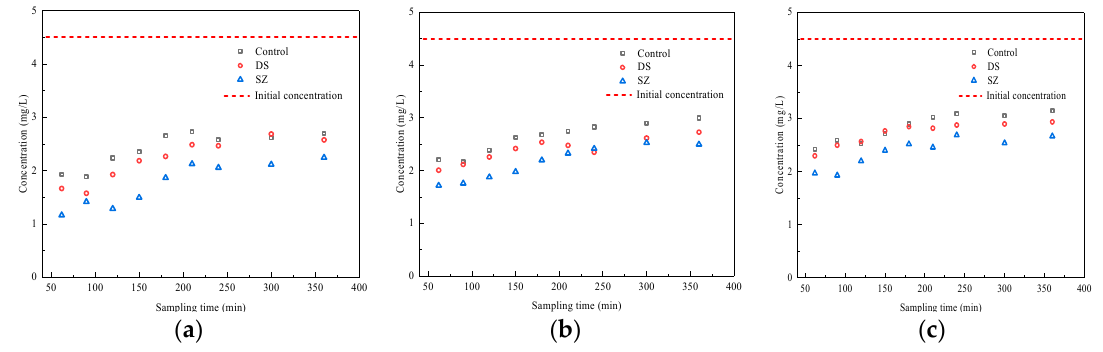
Figure 6. Concentration of TN using bioretention systems with the Control column, DS column, and SZ column under 1a ( a ), 5a ( b ), and 10a ( c ) rainfall intensities.